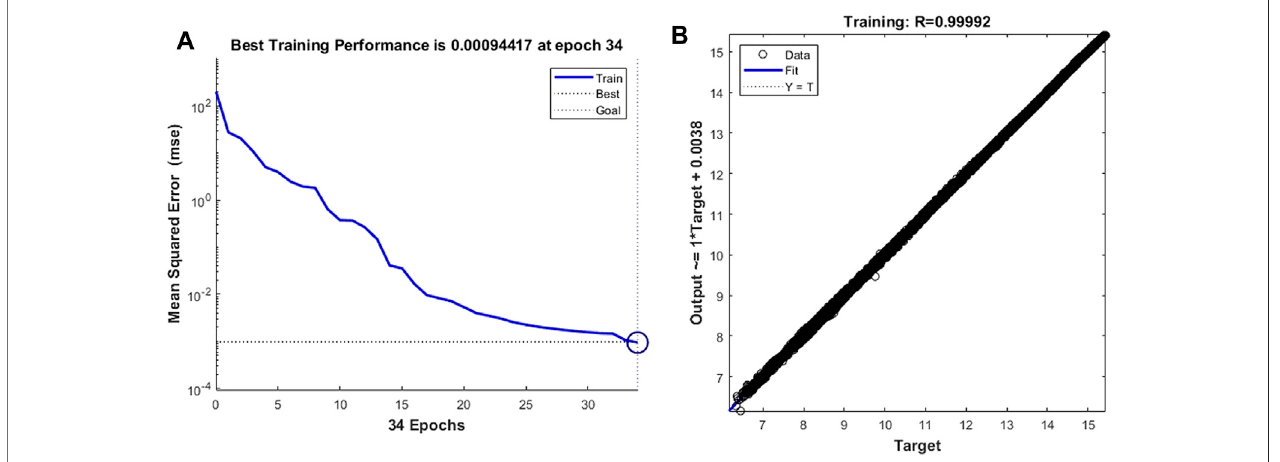
FIGURE 8 | Training performance and fi tting curve of the leukocyte transmigration prediction model for cell deformation prediction (A) Training performance; (B) Fitting curve.